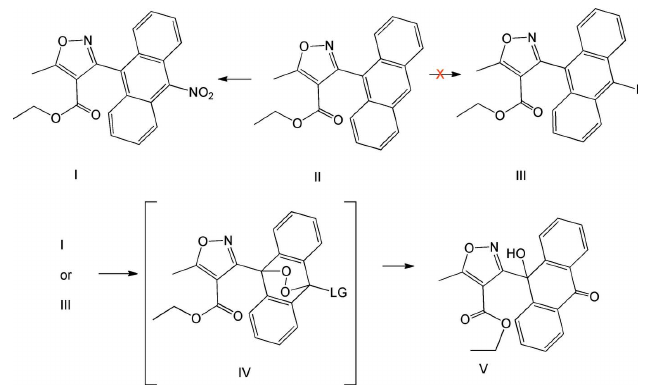
Figure 1 Preparation and molecular structures of the title